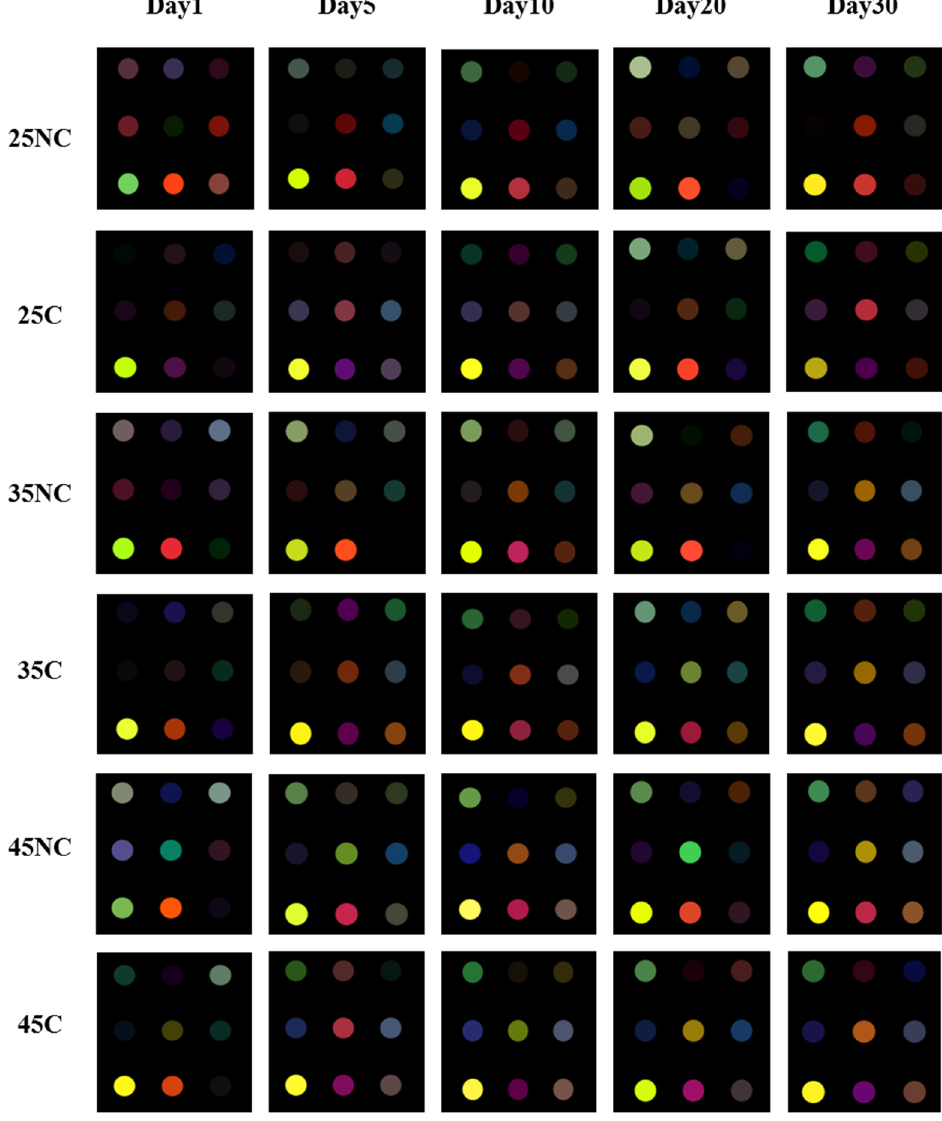
Figure 3. Different images of CSA of boiled-dried anchovy during storage period. From Table 1, three dyes indicating blue, yellow, and red color (No. 1, 5, and 8) exhibited significant color changes, and these were selected as the main dyes for further analysis. It was observed that the color differences between the samples stored for the same incubation period were significantly different for the main target dyes. In